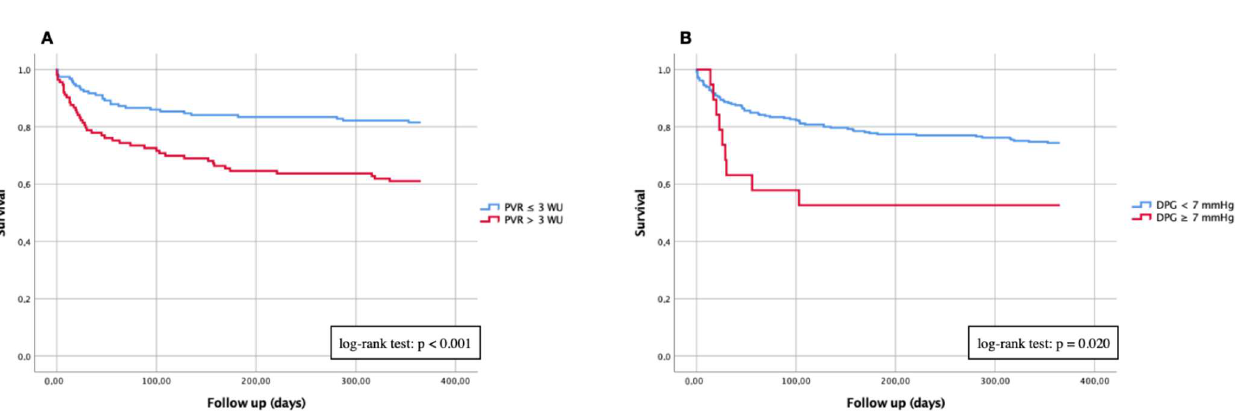
Figure 4. Kaplan–Meier curves of 1-year mortality in patients with severe AS and different expression levels of PVR and DPG. ( A ) Comparison of patients with PVR ≤ 3 WU vs. PVR > 3 WU; ( B ) comparison of patients with DPG < 7 mmHg vs. DPG ≥ 7 mmHg. PVR: pulmonary vascular resistance; DPG: diastolic pressure gradient.